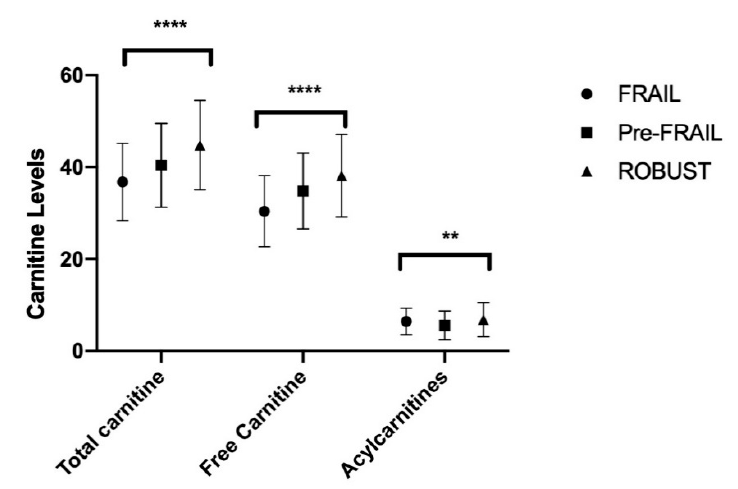
Figure 1. Carnitine in plasma. Summary p value: ** p < 0.005; **** p < 0.0001.